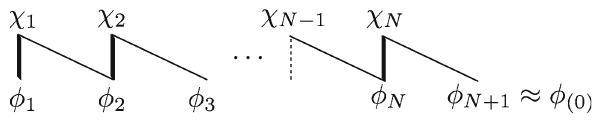
Fig. 1 A clockwork diagram for a chain of scalar